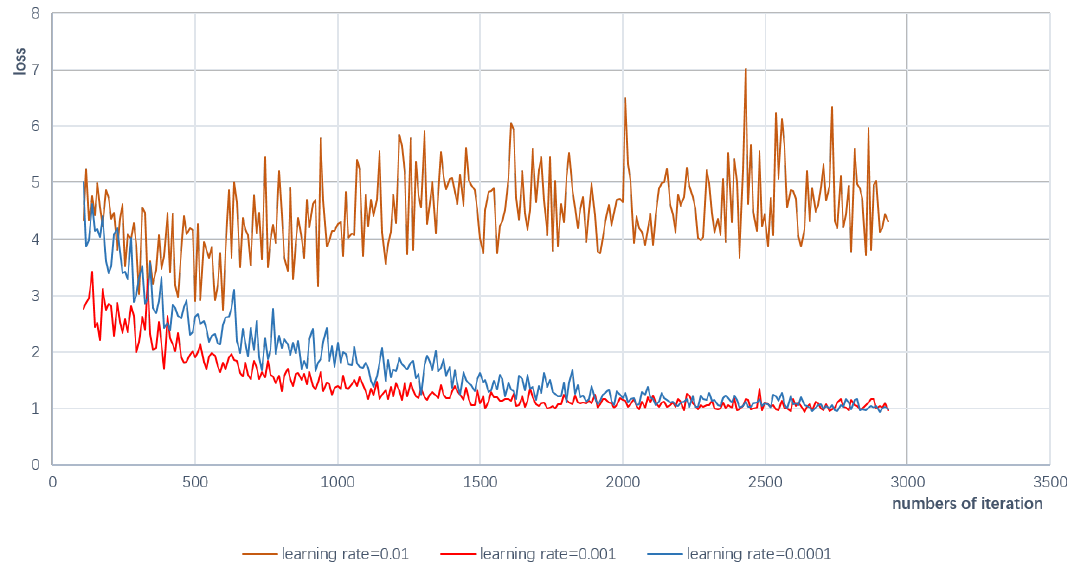
Figure 4. Learning curves demonstration when training in different learning rate. The x -axis represents the number of network iteration, and the y -axis represents the loss during network training.